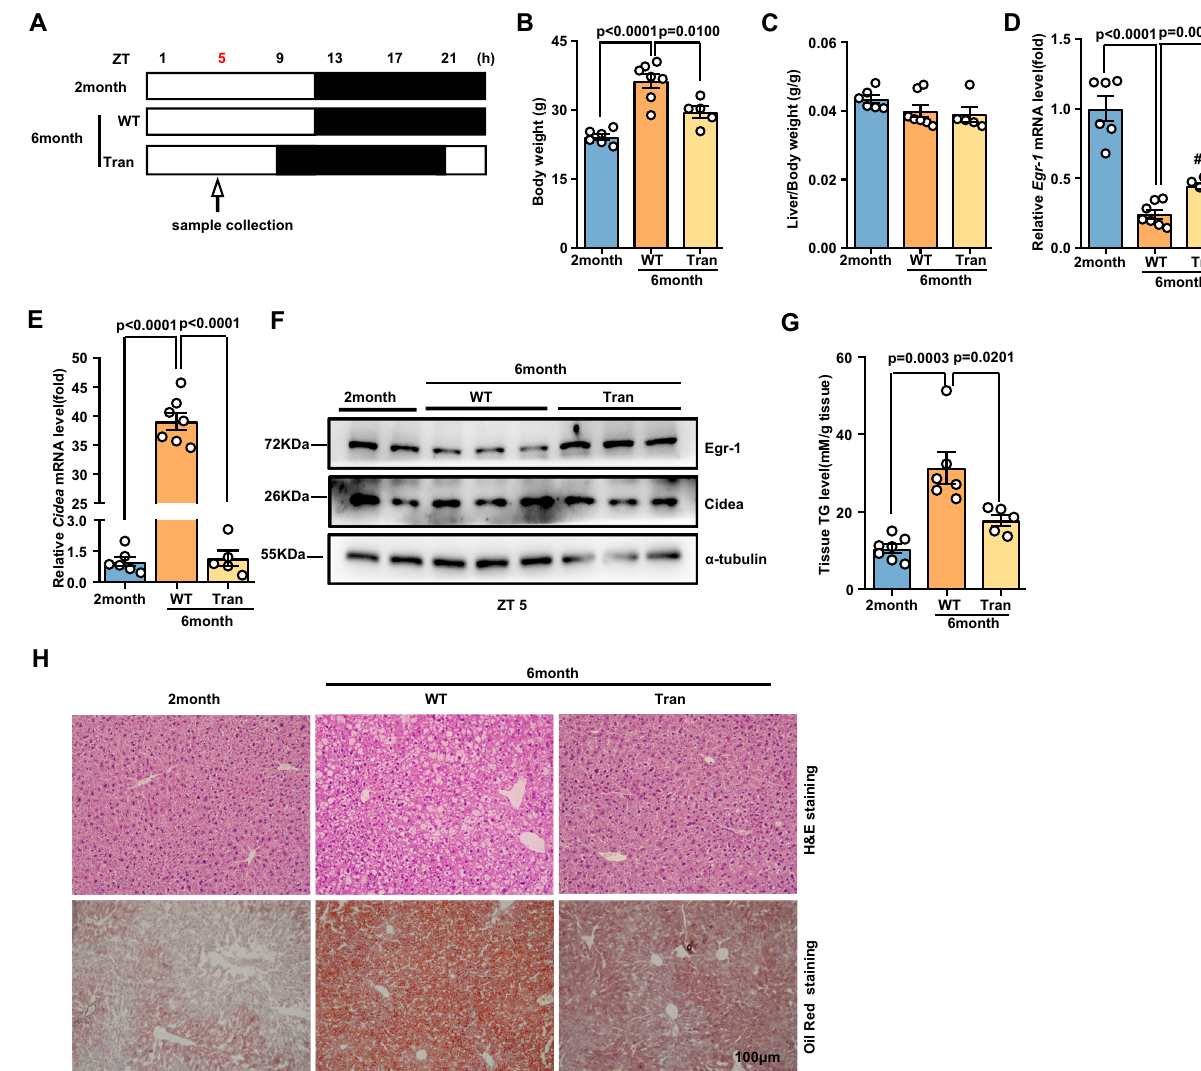
Fig. 7 | Egr-1 phase restoration via a light shift is able to rescue liver metabolic dysfunction. A Design of experiments in which the phase of illumination was advanced4h. B , C Bodyweightsandratiosofliverweight tobodyweightinthe groups at ZT5 (2 months: n = 6; 6 months: n = 7; 6 months Trans: n = 5 biologi- callyindependentanimals). D , E mRNAlevelsof Egr-1 and Cidea inthegroupsat ZT5 (2 months: n = 6; 6 months: n =7; 6 months Trans: n = 5 biologically